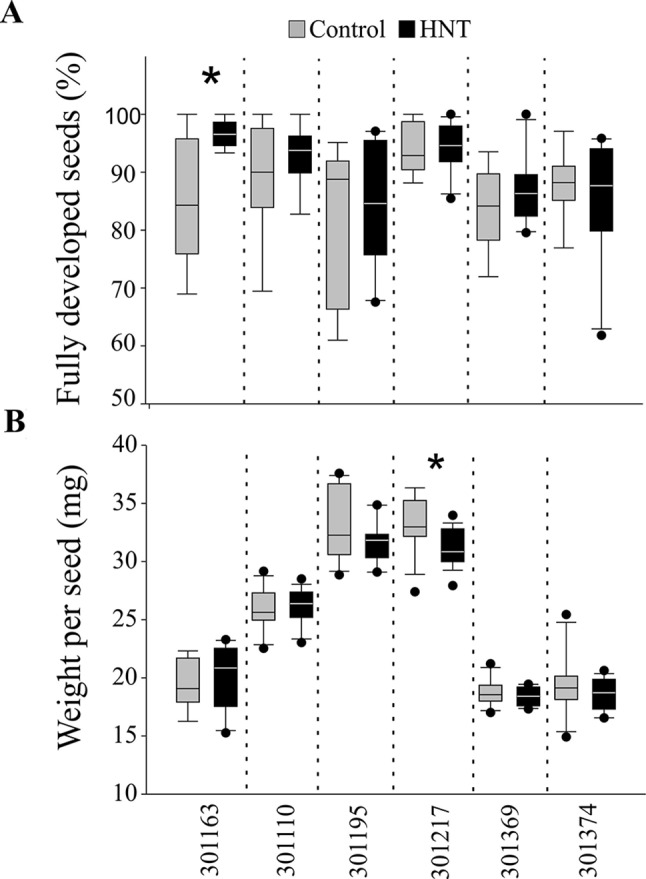
Analysis of mature seeds from control and high night-time temperature treated plants. (A) Percentage of fully developed mature seeds. (B) Weight per seed (in mg). For this, only the marked florets at the time of fertilization were considered (n = 300 – 600) at maturity. One DAF, plants were either kept in control conditions or moved to greenhouse with adjusted HNT until maturity. Data is represented as mean ± standard deviation from eight plants. Student’s t-test was used for statistical analysis (* p < 0.01). HNT: high night-time temperature.